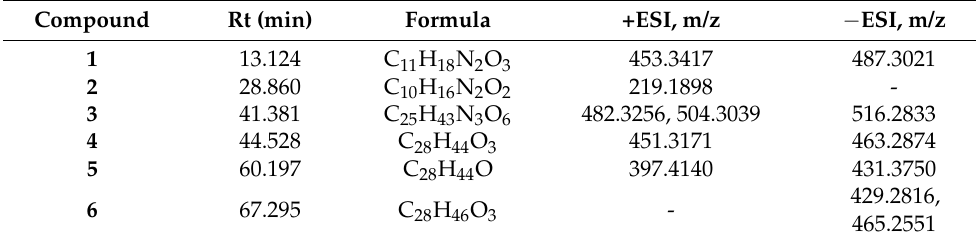
Table 1. LC–MS data of ligands found in fungal extracts.